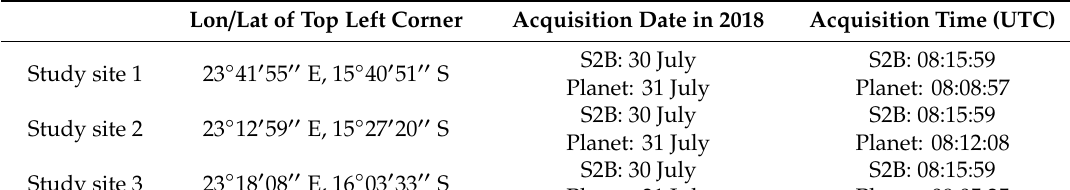
Table 2. Study sites and Sentinel-2B and Planetscope-0 acquisitions.